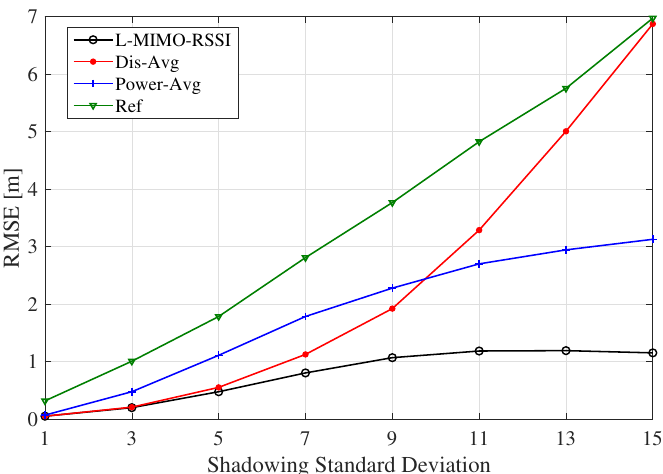
Figure 17. The RMSE for the proposed algorithms for different standard deviation values of shadowing. M = 50, N = 8, α = 1.62.